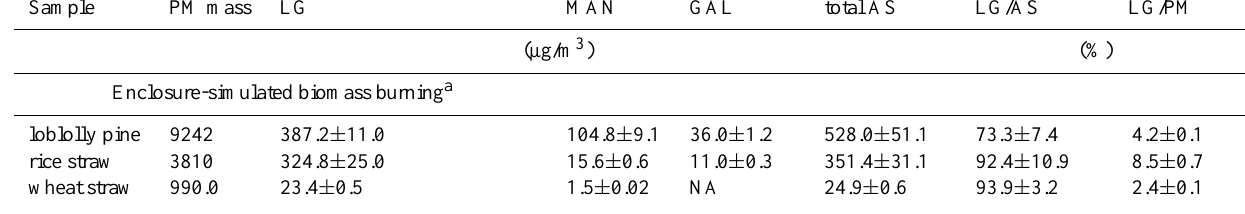
Table 3. Anhydro-sugar concentrations in a variety of biomass burning and atmospheric aerosol samples ( n =3). Sample PM mass LG MAN GAL total AS LG/AS (µg/m 3 ) (%) Enclosure-simulated biomass burning a loblolly